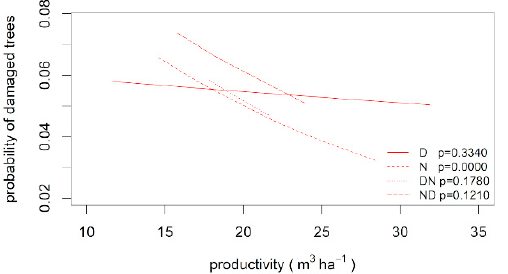
Figure 3. Probability of damage depending on the productivity in different type of shifts (ND—dawn, D—day, DN—dusk, N—night).